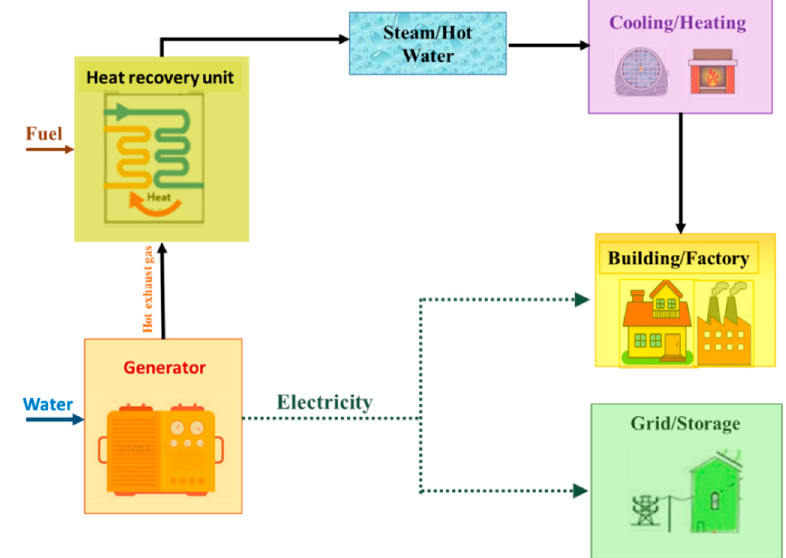
Figure 1. Composition of combined heat and power systems.